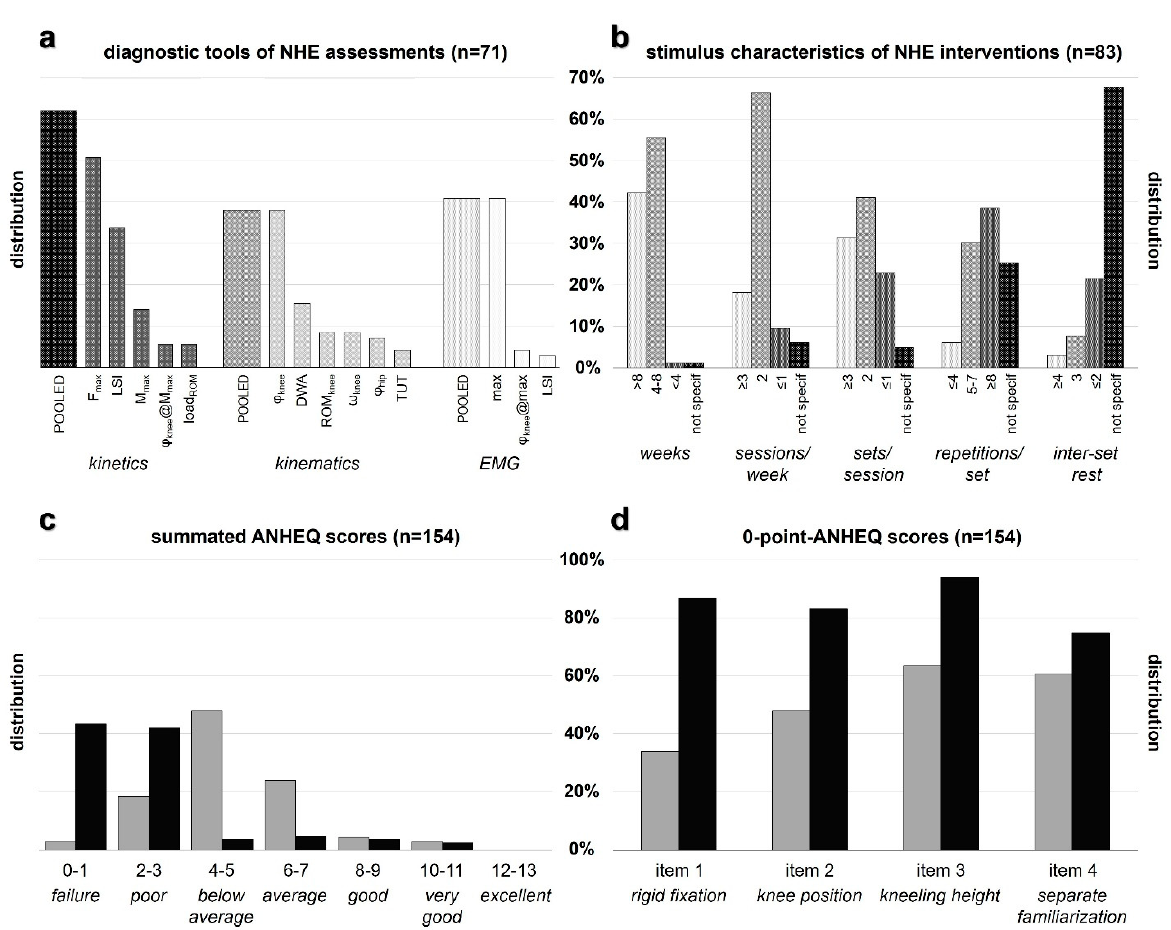
Figure 2. Percentage distributions of ( a ) diagnostic tools and parameters of NHE assessments (pooled according to the corresponding biomechanical measuring procedure) and ( b ) stimulus characteristics of NHE interventions. Total ANHEQ scores ( c ) and 0-point-ANHEQ scores ( d ) are presented for shared ANHEQ items 1–4 of assessments (grey bars) and interventions (black bars). Footnote (abbreviations): NHE, Nordic Hamstring Exercise; F max , peak force; LSI, limb symmetry index; M max , peak moment; φ knee , knee angle; load ROM , load across entire range of motion; DWA, downward acceleration; ROM knee , knee range of motion; ω knee , mean knee angular velocity; φ hip , hip angle; TUT, time under tension; EMG, electromyography; not specif, not specified; ANHEQ, Assessing Nordic Hamstring Exercise Quality.